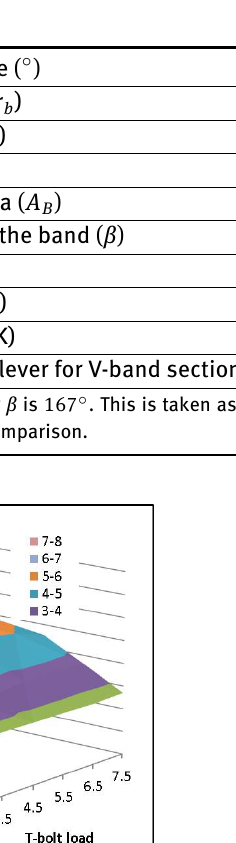
Table 1: Data used in the analyses